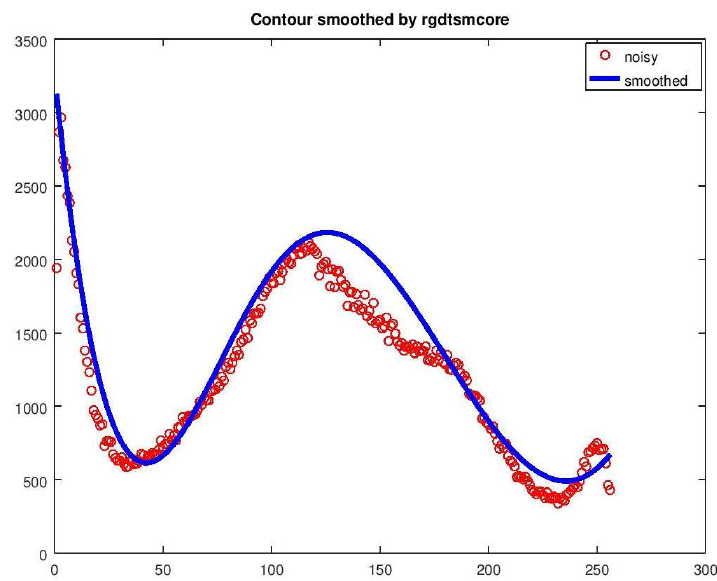
Figure 18. Data-smoothing achieved by rgdtsmcore.